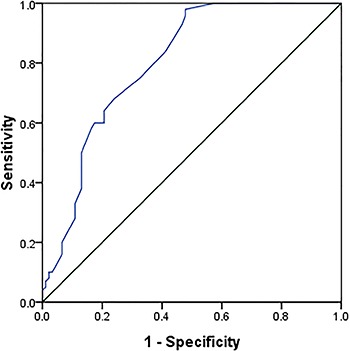
Receiver operating characteristics (ROC) curve analysis for mean platelet
volume (MPV) in patients with polymyositis.